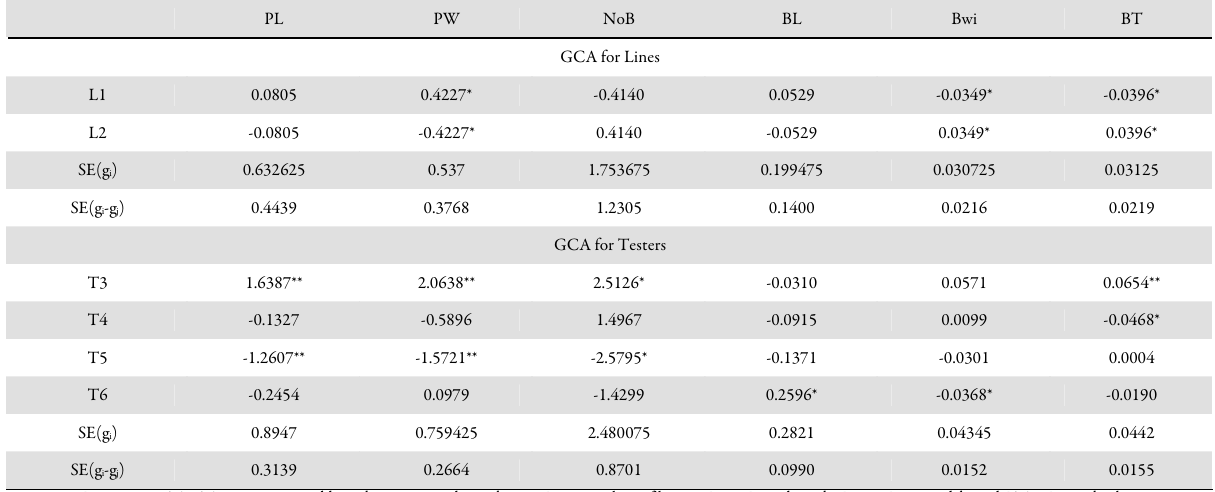
Tab. 5. Estimates of the general combining abilities of the lines and the testers for each of the six